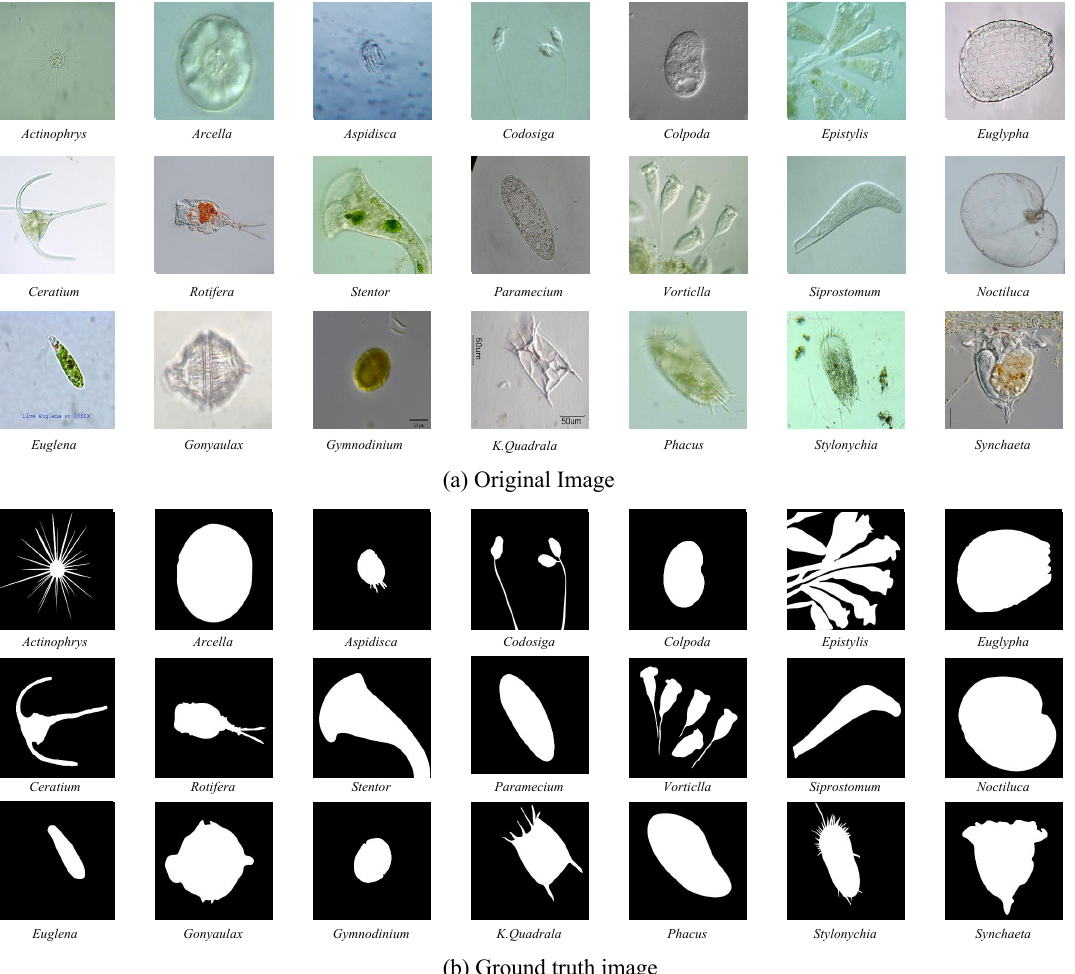
Figure 10. Examples of the environmental microorganism image in EMDS-6. ( a ) is the original images of EMDS-6, each image contains one or more EM objects of the same species, and one image is selected for each species as a representative. ( b ) correspond to the real segmentation images of microorganisms in each image in the ( a ). The pixel value of the background part in the microorganism image is set to 0, and the foreground part is set to